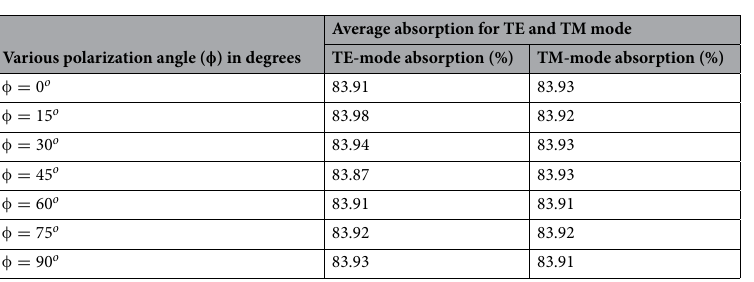
Table 6. Average absorption for different incident angle ( φ ) for TE-mode and TM-mode polarization.